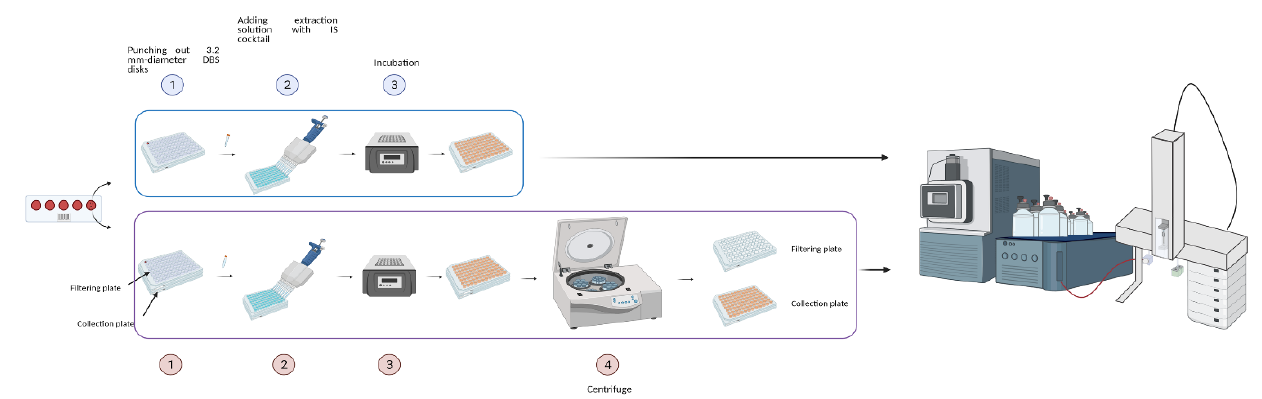
Figure 6. Workflow of sample preparation using NeoBase™ 2 (on the top panel remarked in light blue) and MassChrom ® (on the bottom panel remarked in light violet) non-derivatized kits by parallel analysis on the RenataDX Screening System. Image created with BioRender.com.